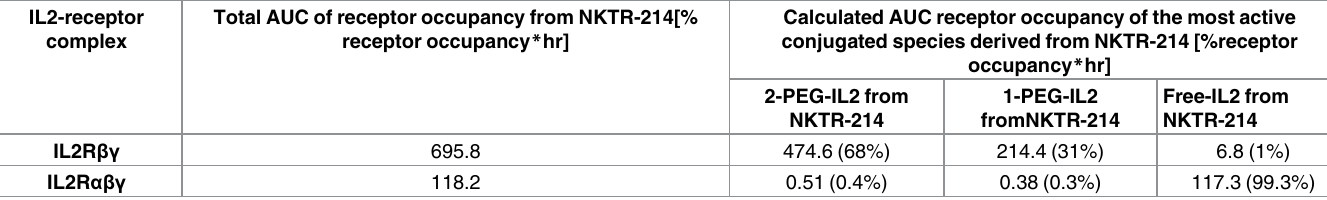
Values in parenthesis show percentage contribution of each conjugated-IL2 species derived from NKTR-214 relative to total receptor occupancy AUC from all